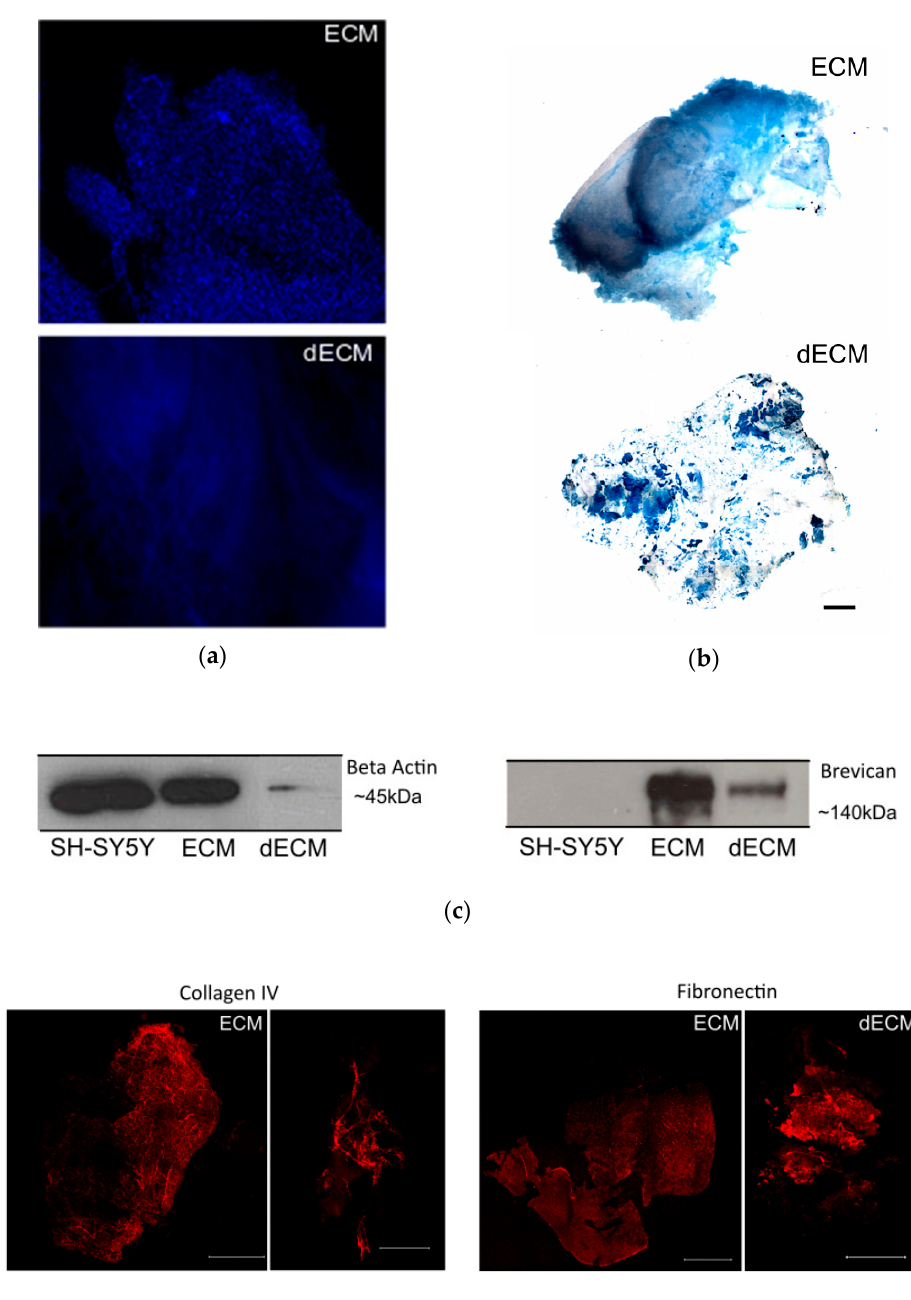
Figure 2. Decellularization of the striatal sections. ( a ) Non-decellularized (ECM) and decellularized (dECM) sections (250 μ m thickness) from the striatum region of a C57/BL6 mouse brain stained with the nuclear dye DAPI (in blue) to assess the removal of cellular components; scale bar 100 μ m. ( b ) The Alcian Blue staining of the ECM and dECM slices highlight the preservation of the glycosaminoglycans; scale bar 800 μ m. ( c ) Detection of intracellular protein actin (left) and proteoglycan brevican (right) by Western blot. It was possible to confirm the reduction of the cellular content and the preservation of ECM components on the dECM samples, respectively. Actin was present in high amounts in the solubilized non-decellularized ECM slices and in the lysate of the SH-SY5Y control cell line, whereas it was drastically reduced in the solubilized dECMs. ( d ) Immunostaining of collagen IV and fibronectin proteins in both ECM and dECM slices. The scale bar for ECM images is 1500 µ m, while for the dECM collagen IV image it is 500 µ m and for the dECM fibronectin image it is 1500 µ